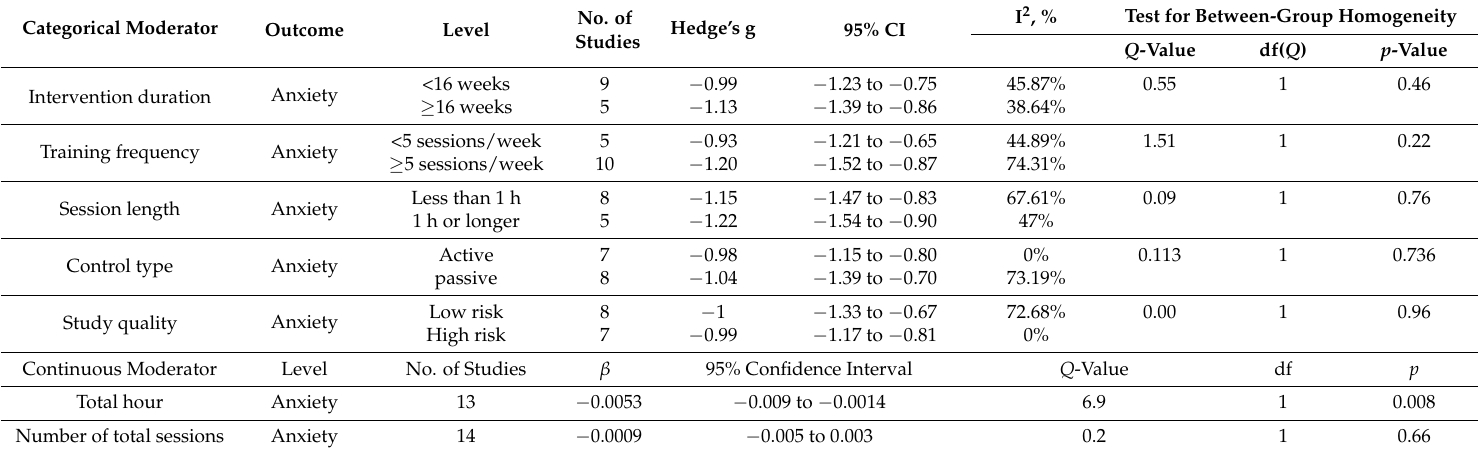
Table 4. Moderator analysis for Baduanjin versus control group.